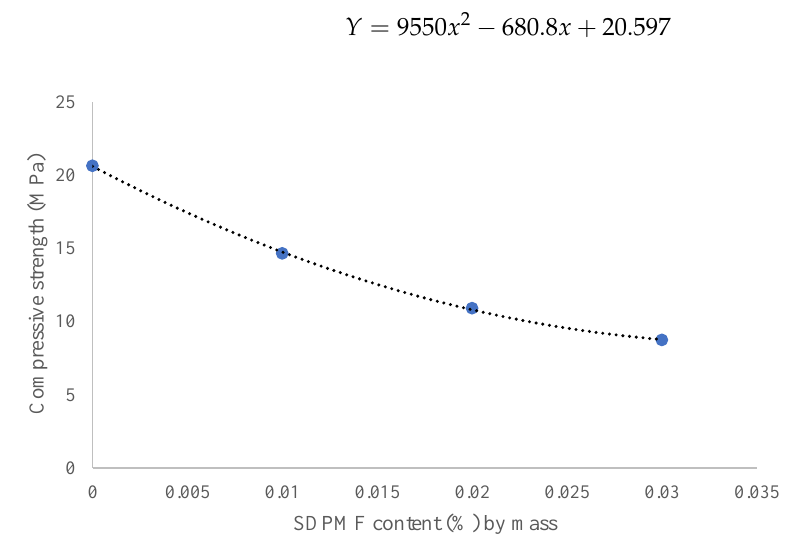
Figure 10. Best fit curve of SDPMF mortars’ compressive strength. formance. Mortars containing 1% and 3% SDPMF showed lower loss of compressive strength with 29.01% and 57.66%, respectively, compared to 50.30% and 83.91% for mortars larger tuft of SDPLF leaves (5 mm) that weakening the bonding of the mortar